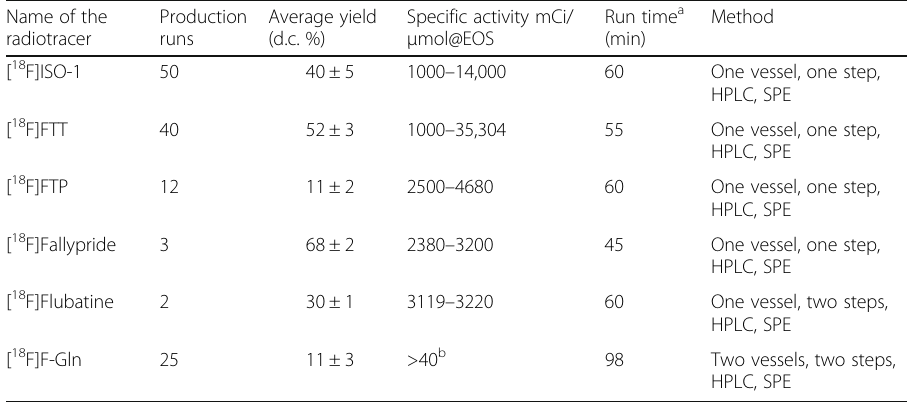
Table 1 Labeling methods and yields Name of the